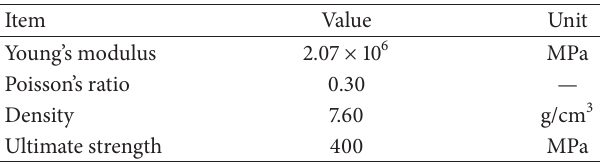
Table 1: The properties of used materials in simulation of structural